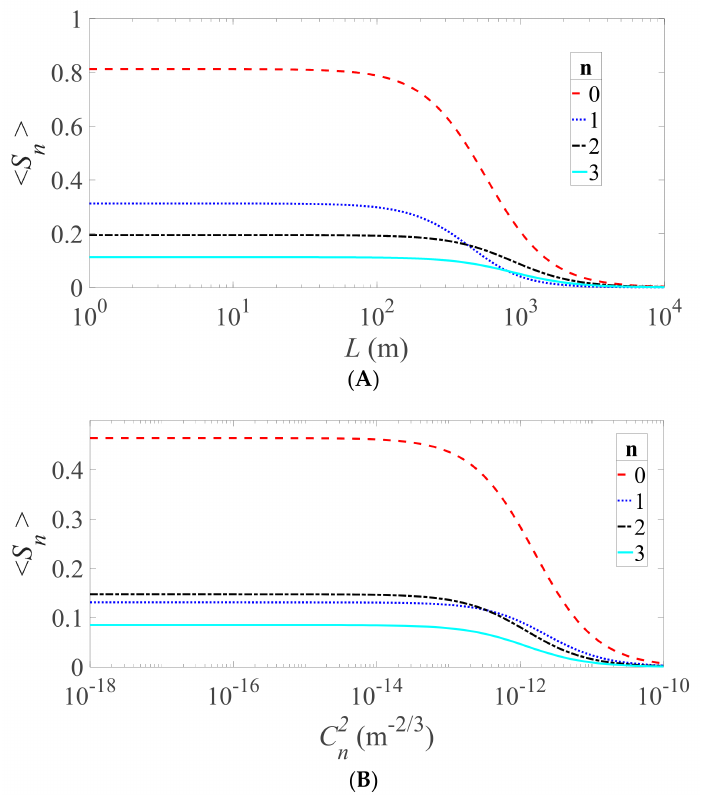
Figure 1. Average Stokes parameters versus ( A ) propagation distance L and ( B ) refractive index structure parameter C 2 n . Figures 1B, and 2: same parameters with Figure 1A and L = 500 mm.